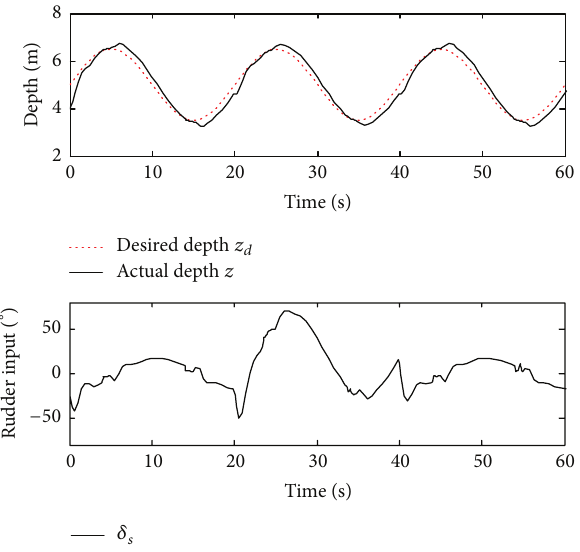
Figure 11: ATSMC based on NDO without integer part Ω 1